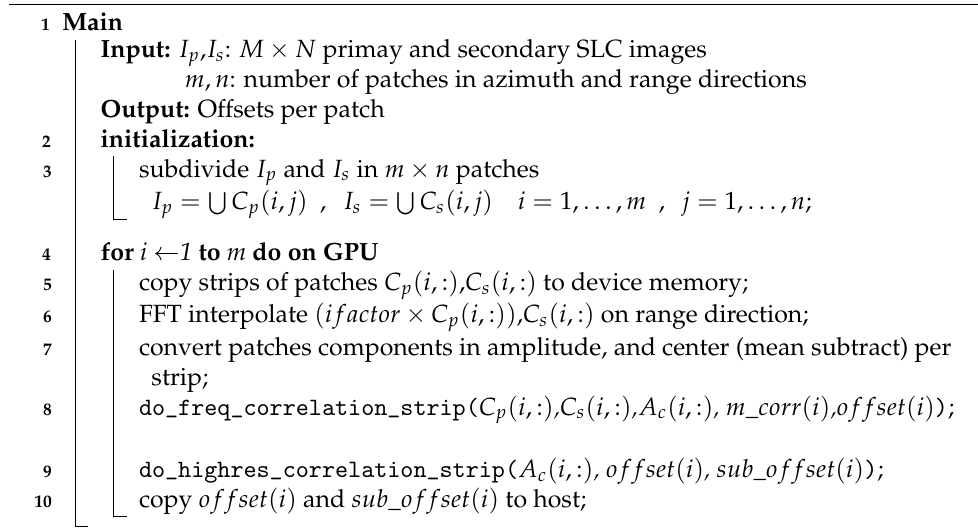
Algorithm 2: GPU-parallel main